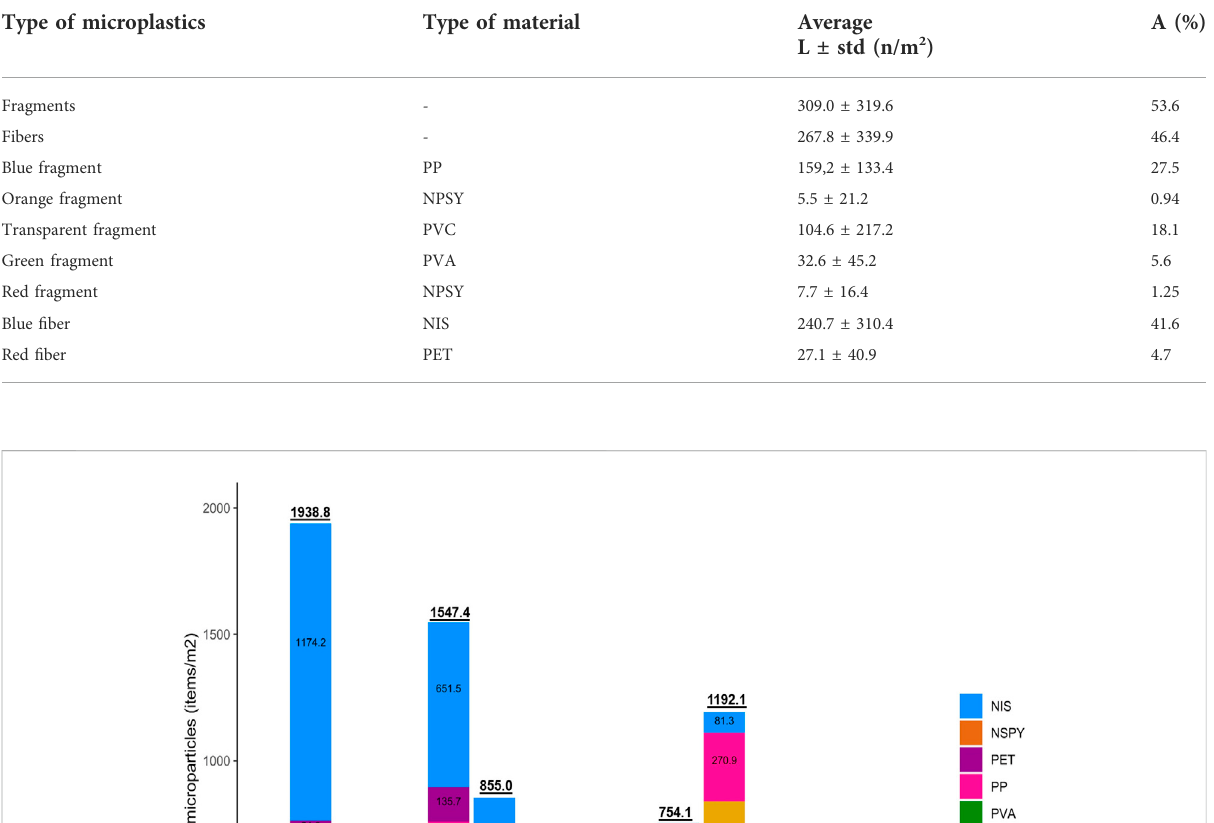
TABLE 1 Microplastics in the study area. PP – Polypropylene, NPSY – Naplesyl, PVC – Polyvinyl Chloride, PVA – Polyvinyl alcohol, NIS – Non-identi fi ed Synthetic, PET – Polyethylene terephthalate. L stands for levels and std for standard deviation. A is the relative abundance for the study area.